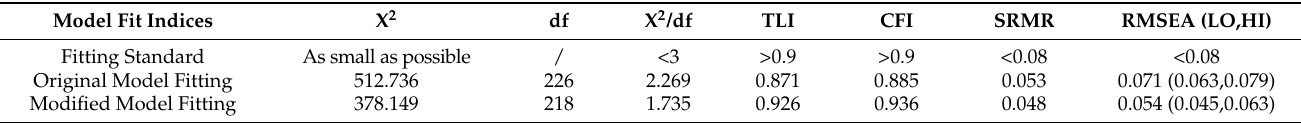
Table 7. Model Fit Indices.